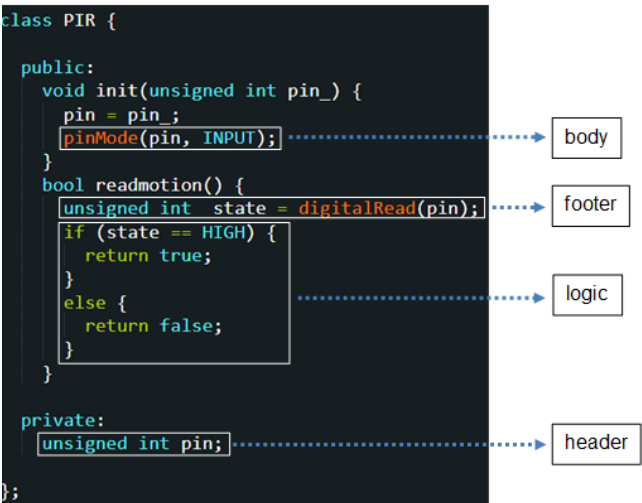
Figure 6. Example of a class that abstracts a PIR sensor for IRArduino-SPL where the main program- ming idioms encountered in domain engineering are